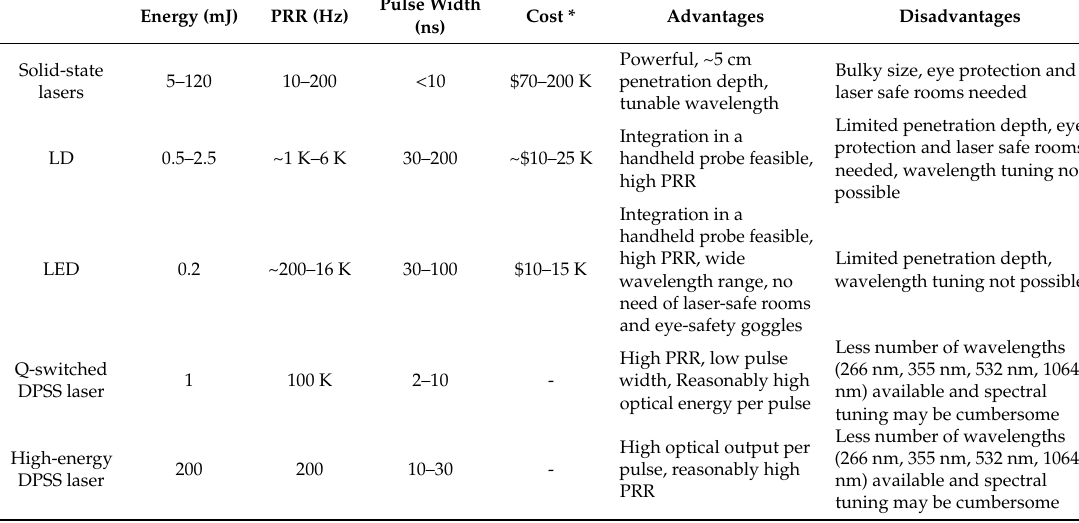
Table 1. Comparison of di ff erent light sources used in photoacoustic imaging. * Cost includes the driving electronics and may vary based on di ff erent features, number of wavelengths, etc. Integration to a US probe may also involve extra development cost. LD, Laser diode; LED: Light-emitting diode; DPSS: Diode-pumped solid-state; PRR, pulse repetition rate. Adapted with permission from Y. Zhu,